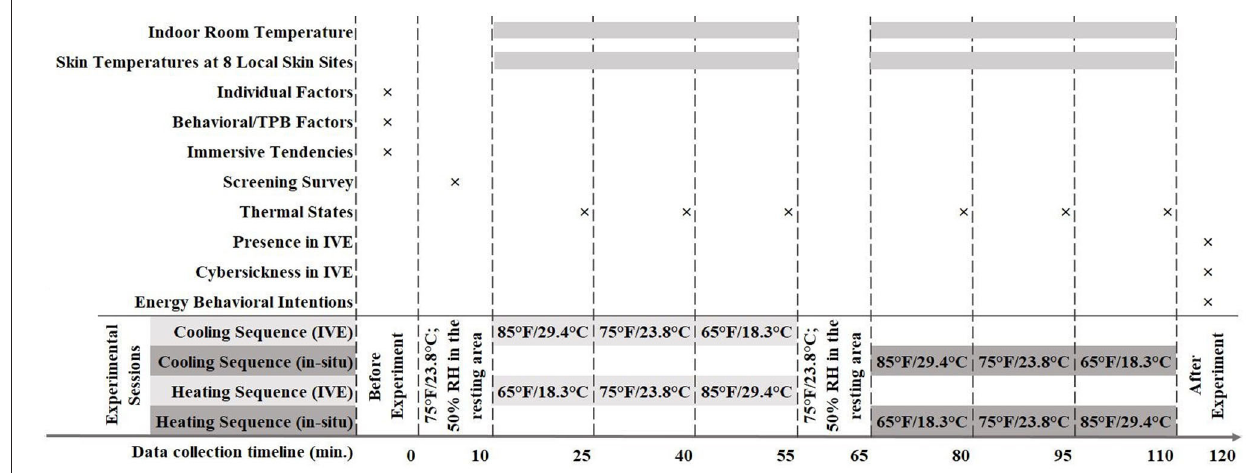
FIGURE 2 | Experiment and data collection procedure.